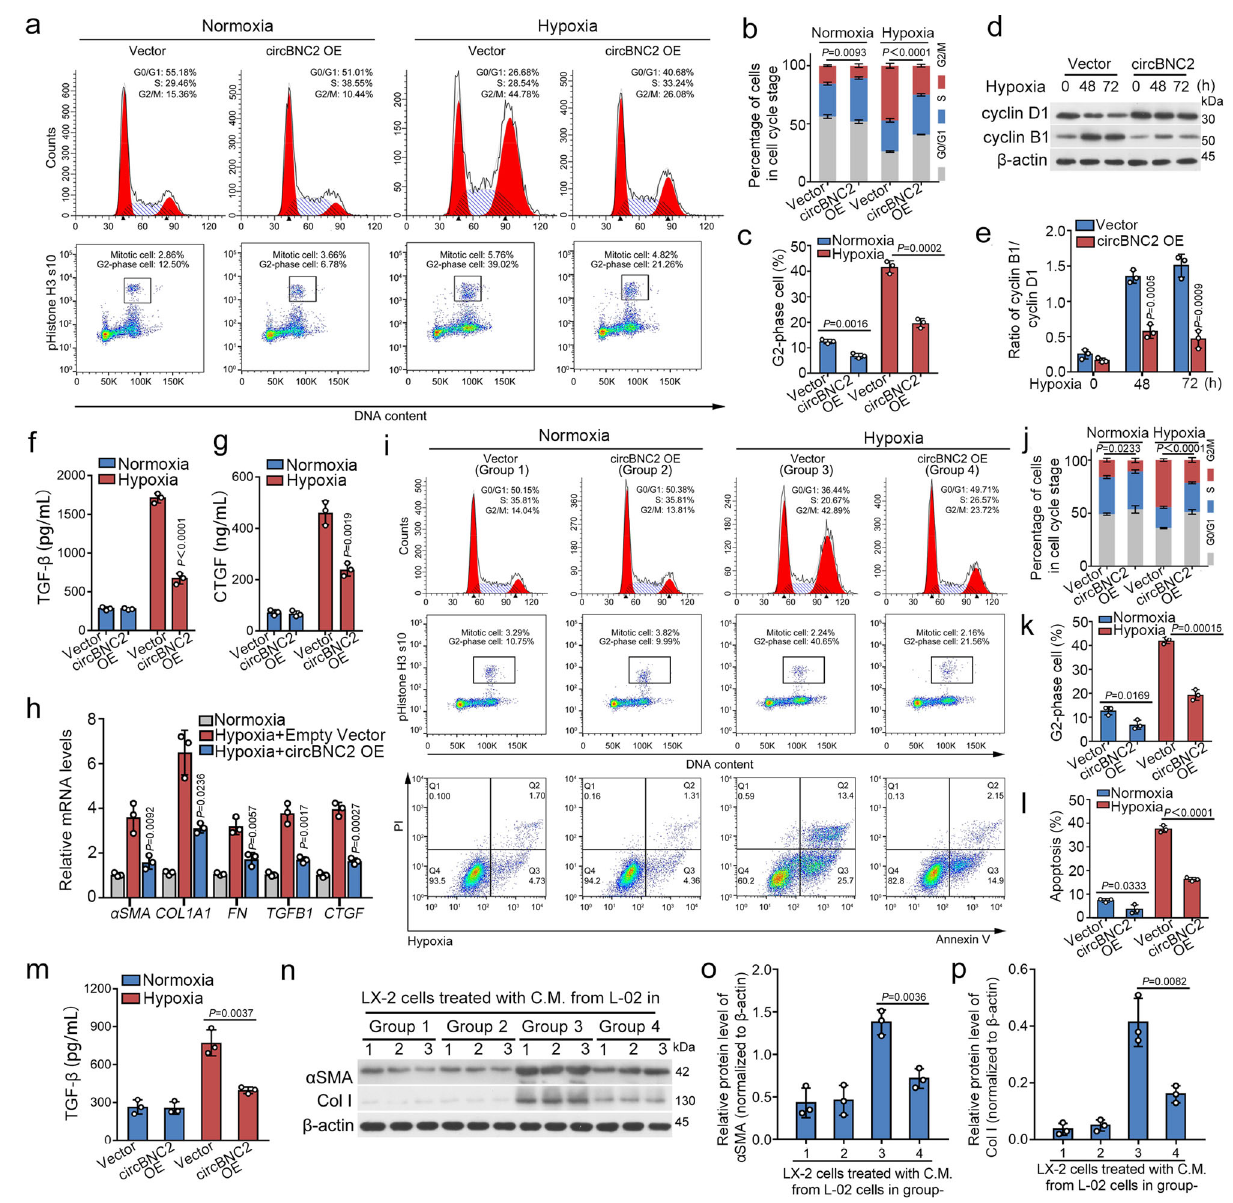
Fig. 3 | Ectopic expression of circBNC2 attenuates epithelial cell G2/M arrest after injury. a – c Cell cycle analysis by fl ow cytometry in HK2 cells showing over- expressionofcircBNC2reduced72-hhypoxia-inducedG2/Mcellcyclearrest( a , b ), especially G2 phase cell cycle arrest ( c ). d , e Western blots showing the expression of cyclin B1 and cyclin D1 ( d ) and the quanti fi cation of cyclin B1/cyclin D1 ( e ). f , g Secretion of TGF- β 1 ( f ) and CTGF ( g ), determined by ELISA, in 72h hypoxia- treated HK2 cells transfected with circBNC2 or empty vector. h qRT-PCR showing mRNA levels of pro fi brotic factors expression in 72h hypoxia-treated HK2 cells transfectedwithcircBNC2oremptyvector. i – l Cellcycleanalysisby fl owcytometry in L-02 cells showing overexpression of circBNC2 inhibited G2/M cell cycle arrest andcellapoptosisinducedby72-hhypoxiatreatment.ThesupernatantsfromL-02